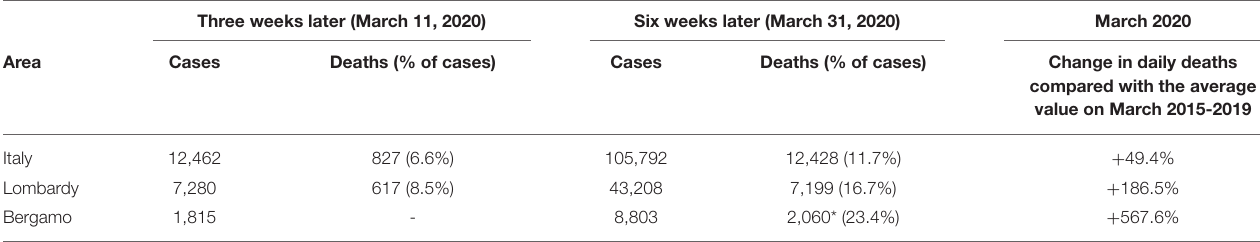
TABLE 1 | Number of cases and deaths due to Covid-19 in Italy, Lombardy, and province of Bergamo in the weeks after Atalanta—Valencia CF football match held on 19th February.